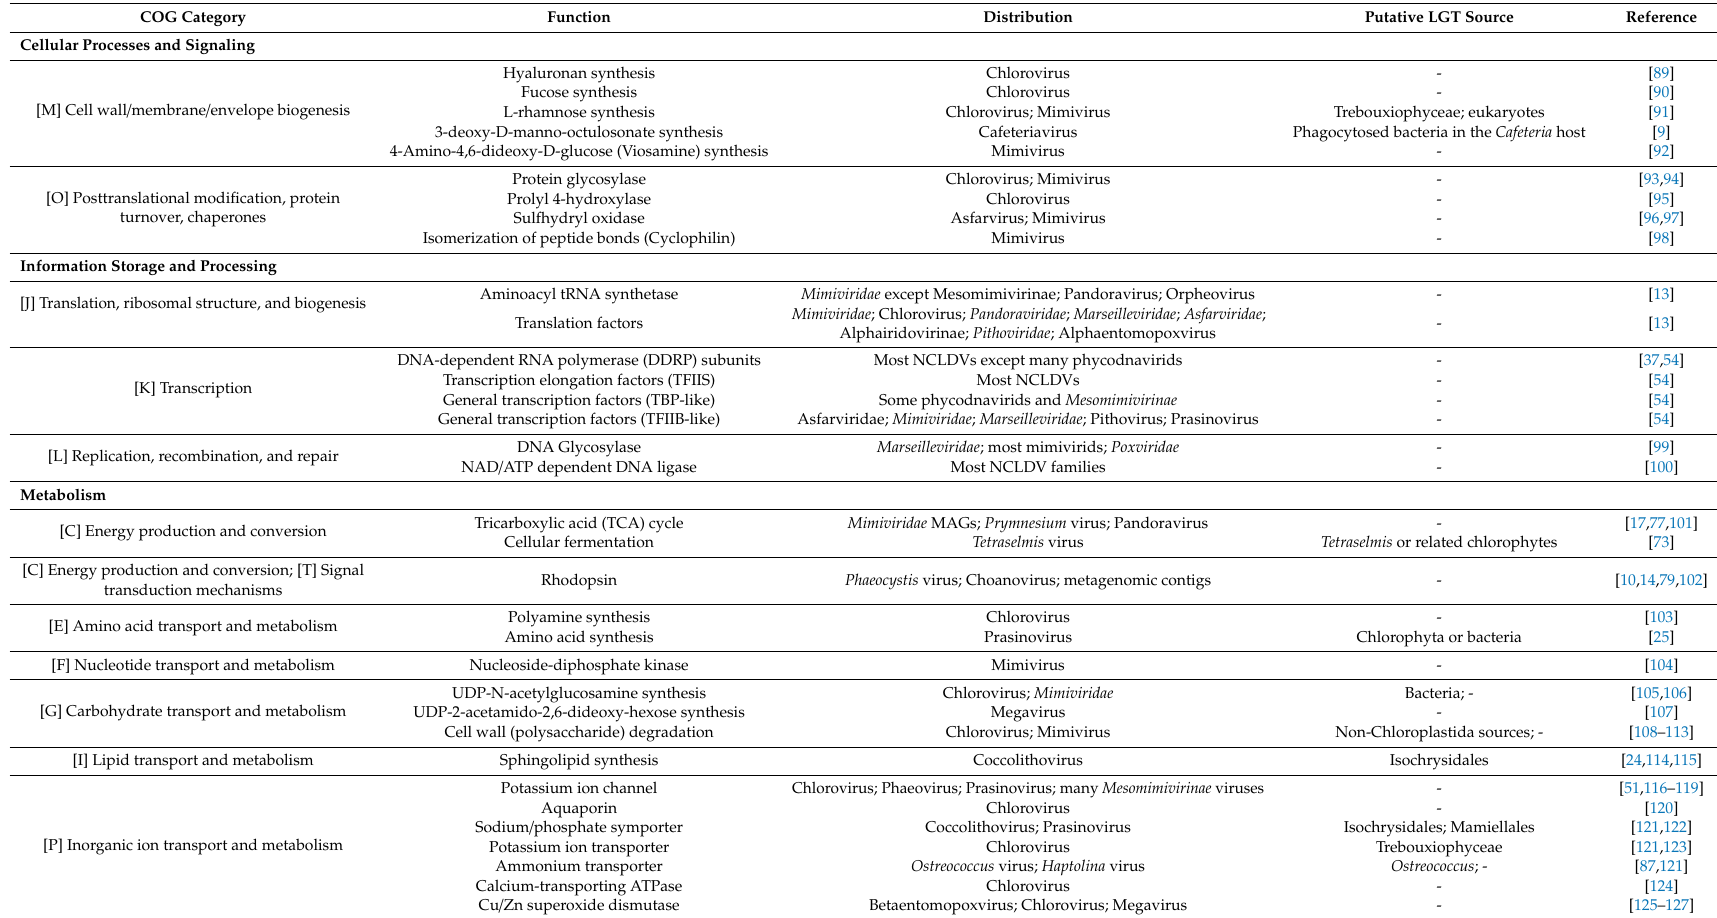
Table 2. A glimpse of the functional diversity of protein-encoding genes in giant